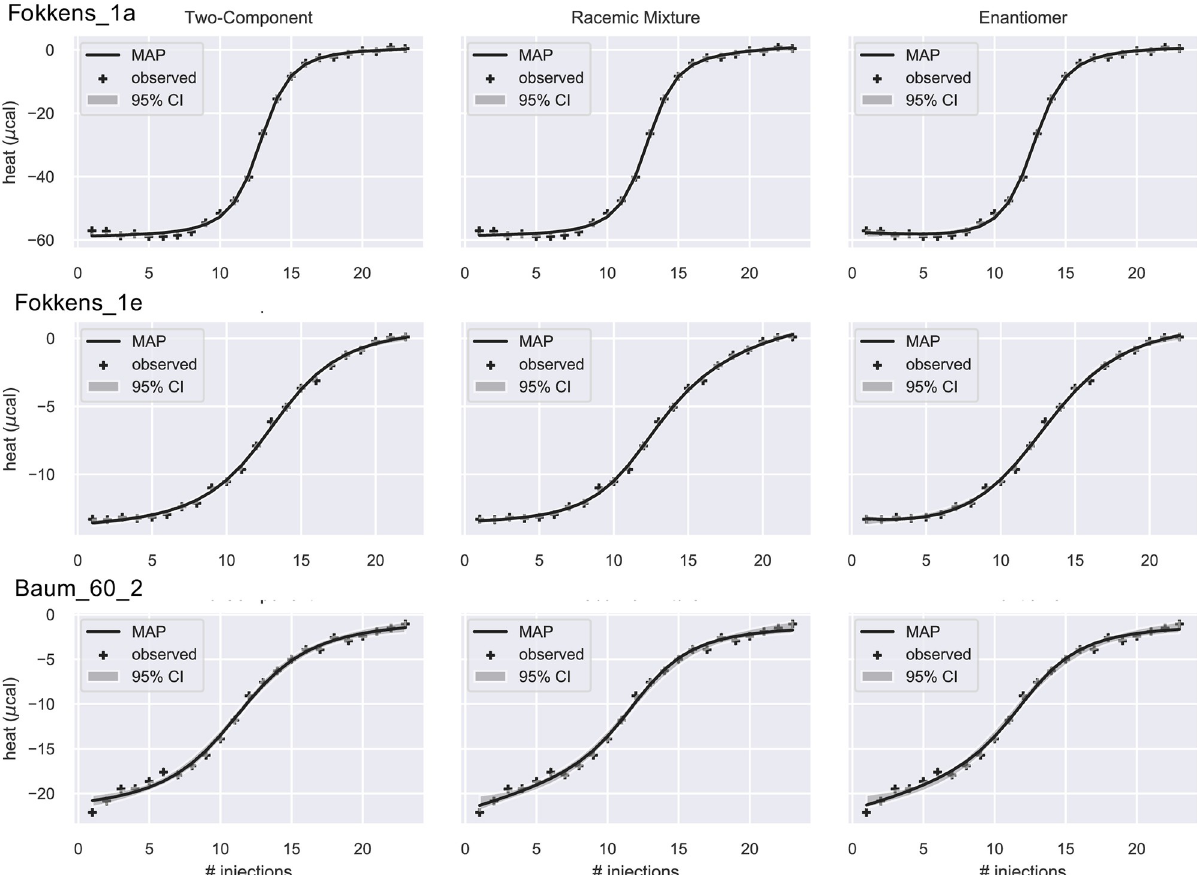
Fig 5. Model fits to integrated heat data. The data were fitted by the 2C (left), RM (middle), and EM (right) models. The solid line is the theoretical heat q � ð θ Þ , where θ MAP is the Maximum a Posteriori estimate of the parameters. The grey band is the 95% confidence interval. Crosses are the MAP n observed heat. The three datasets are best fitted by the 2C model according to the estimated Bayes factors (Table 3).